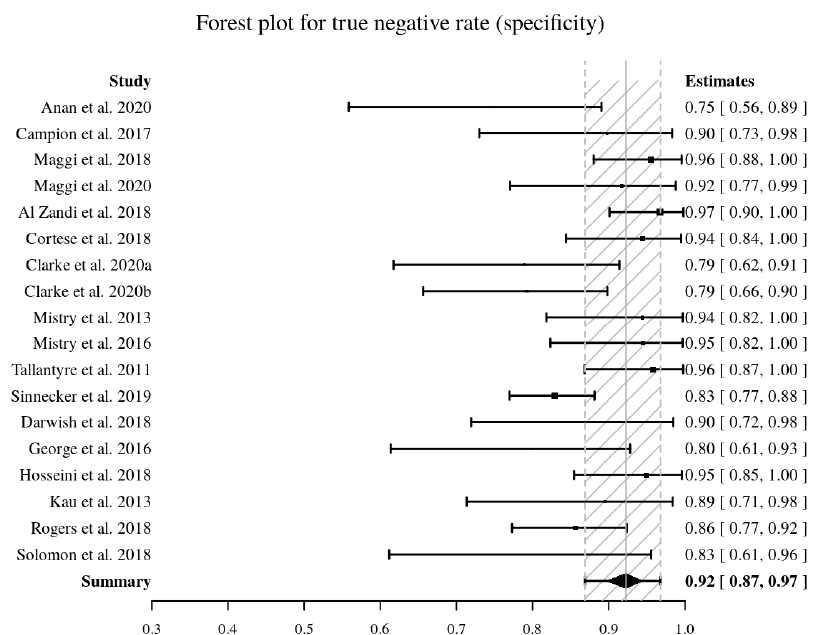
Figure 5. Forest plot of pooled specificity (in bold) of the central vein sign in T2*-weighted images for differentiating MS from other mimicking diseases. Specificity values are reported with estimated 95% confidence intervals (CIs) for each study included.